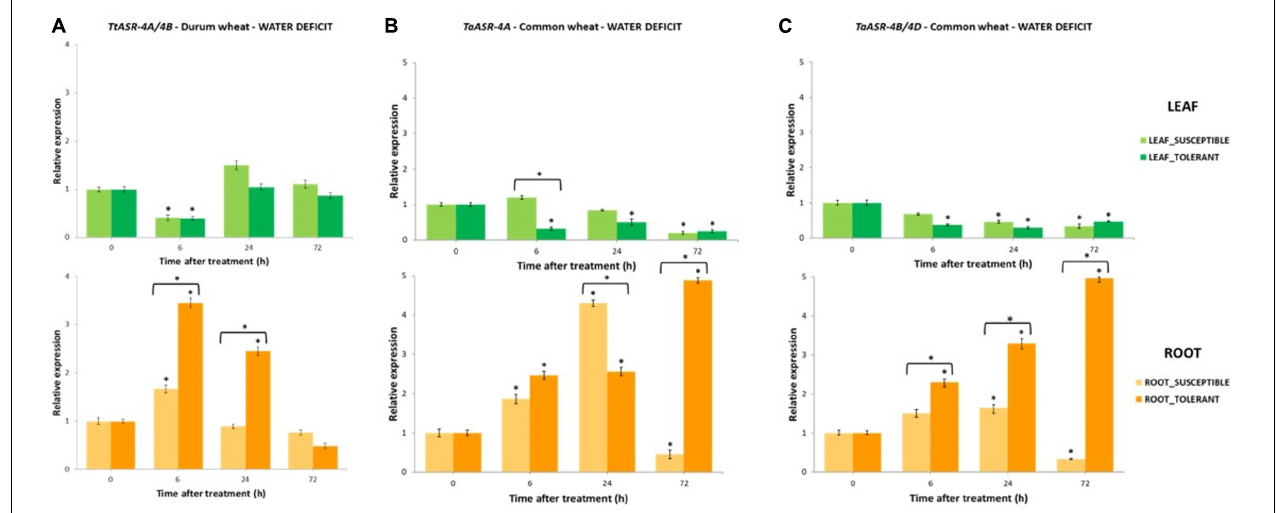
FIGURE 5 | The qRT-PCR time-course expression of ASR genes in drought-susceptible and drought-tolerant Tunisian genotypes of tetraploid and hexaploid wheat after 15% PEG application. Gene expression was measured in leaves and roots at 0 (control, not treated, set to 1), 6-, 24-, and 72-h post-treatment. Expression values are reported as fold-changes relative to control, normalized against an internal reference ( Actin ). Data represent the mean ± SD of three technical replicates (vertical bars). Asterisks indicate data significantly different between samples and control (* on bars) or between susceptible and tolerant genotypes (* over two bars), according to Student’s t -test (* p < 0.05). (A) Expression profile of TtASR genes from 4A and 4B chromosomes of durum wheat in drought-susceptible (HmiraK11835 S ) and drought-tolerant (HmiraK11857 T ) genotypes. (B) Expression profile of TaASR gene from 4A chromosome of common wheat in drought-tolerant